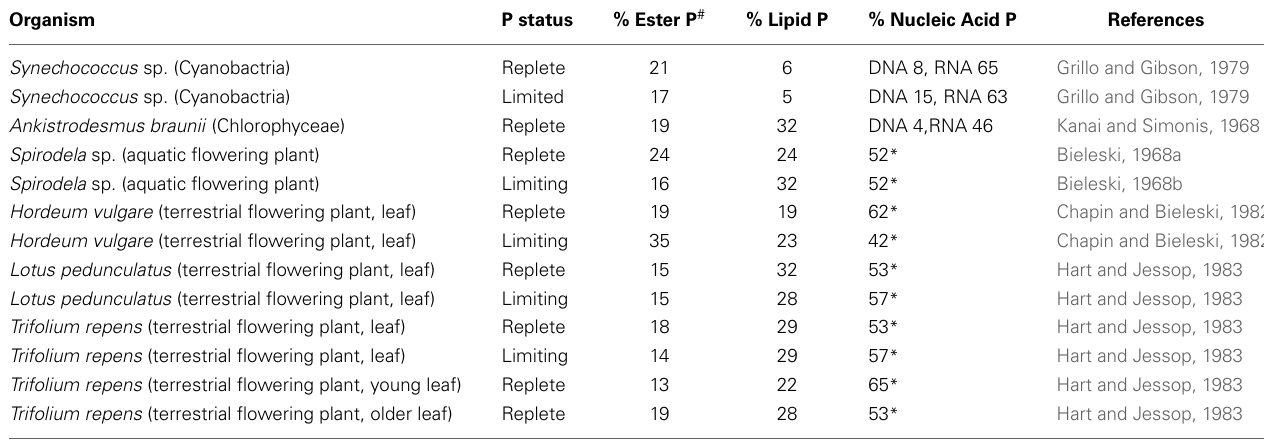
Table 2 | Percentage of total non-storage phosphorus in the major phosphorus-containing fractions of a cyanobacterium, a green microalga, an aquatic flowering plant and four terrestrial flowering plants as a function of phosphorus supply and organ